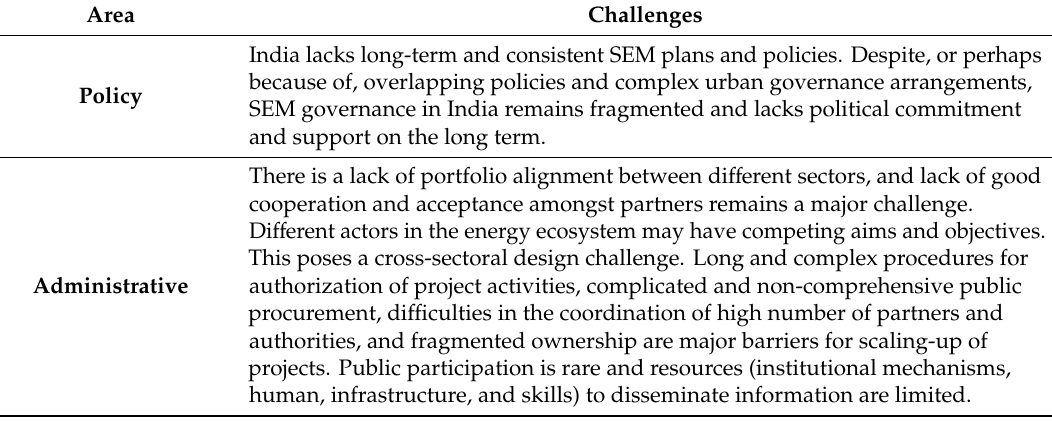
Table 1. PASTEL (Political, Administrative, Socio-environment, Technological, Economic, and Legal) analysis for SEM in India.